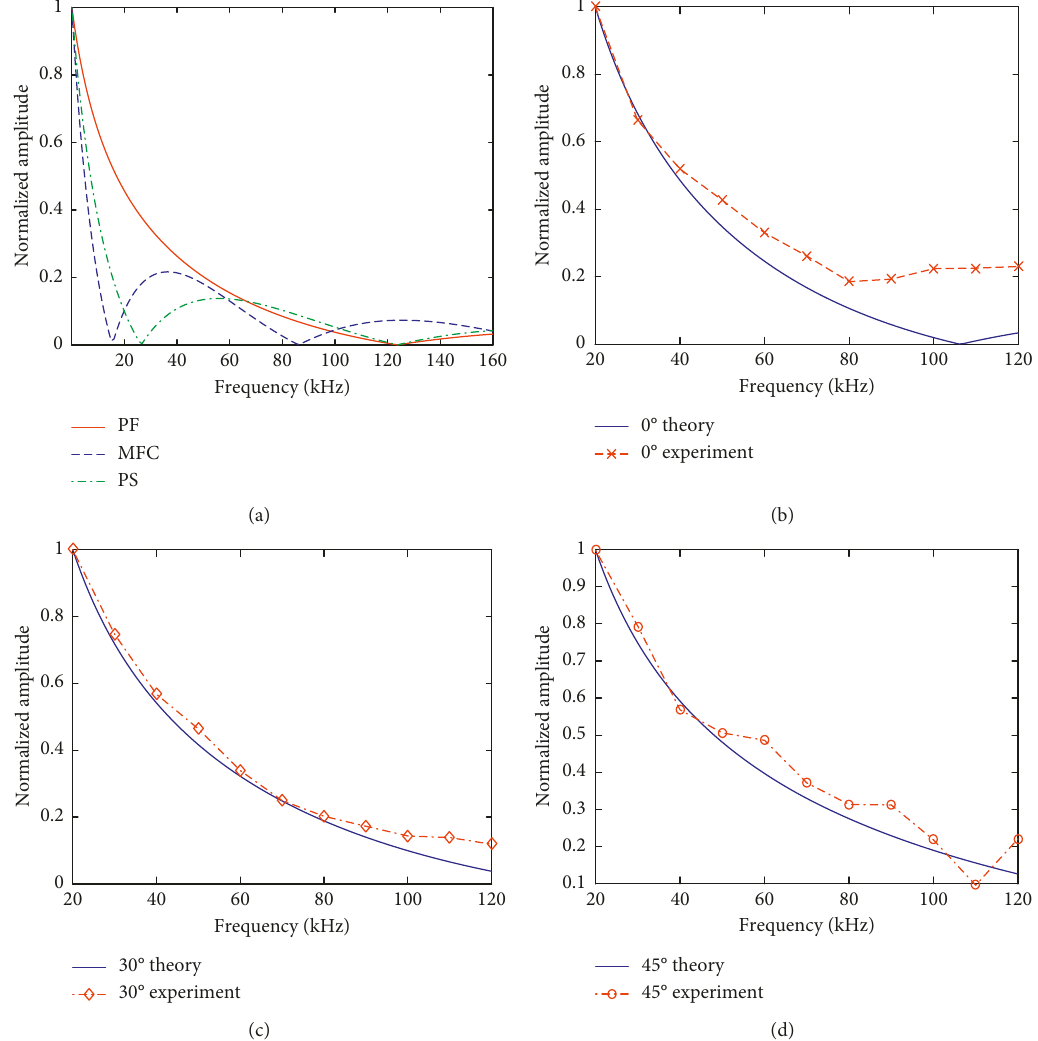
Figure 10: (a) Theoretical and experimental response amplitude spectra of the piezoelectric fiber at (b) 0 ° , (c) 30 ° , and (d) 45 °